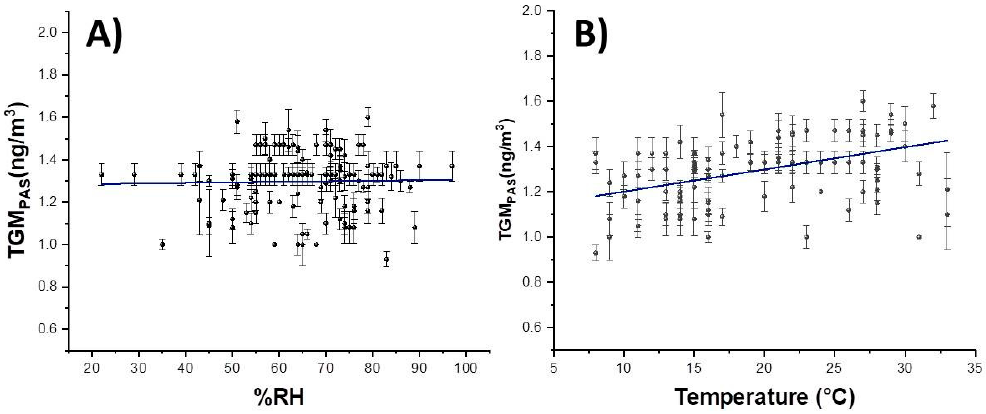
Figure 9. Linear fittings of collected data vs. %RH ( A ) and T ( B ) values.